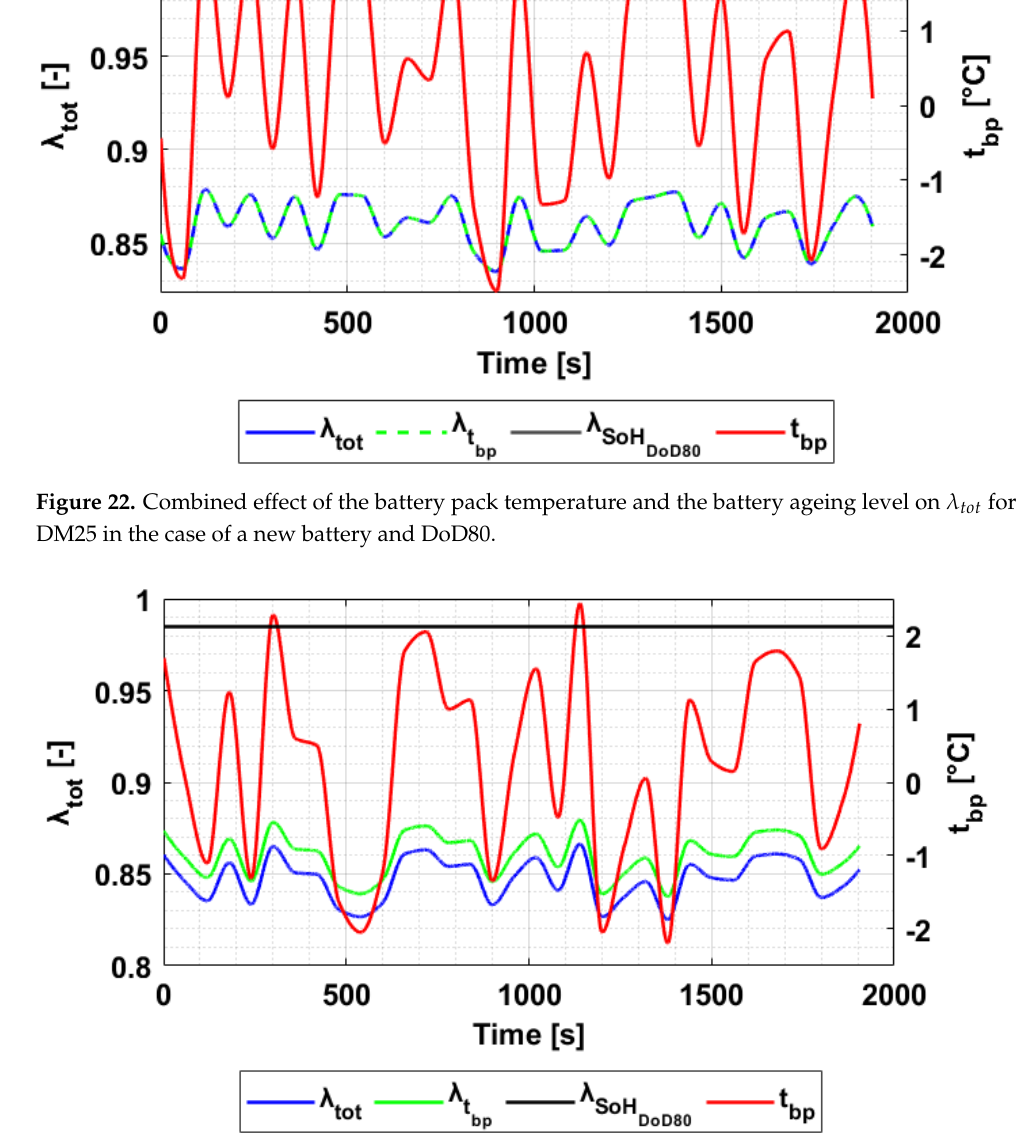
Figure 24. Combined effect of the battery pack temperature and the battery ageing level on 𝜆 𝑡𝑜𝑡 for DM25 in the case of a battery with 400 life-cycles completed and DoD80.